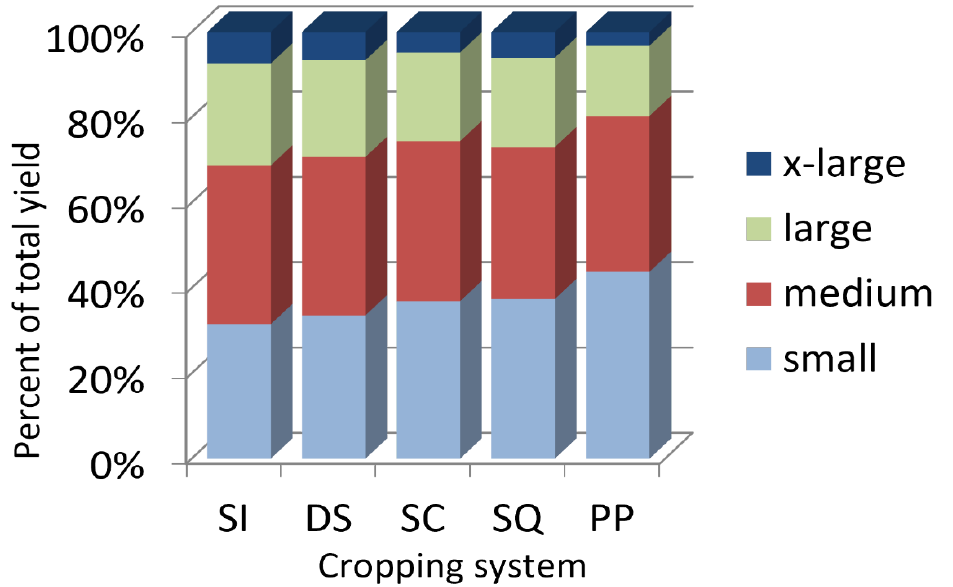
Figure 3. Effect of cropping system (SQ—standard rotation, SC—soil conserving, SI—soil improv- ing, DS—disease suppressive, and PP—nonrotation control) on tuber size class distribution from combined data over four cropping seasons (2015–2018).